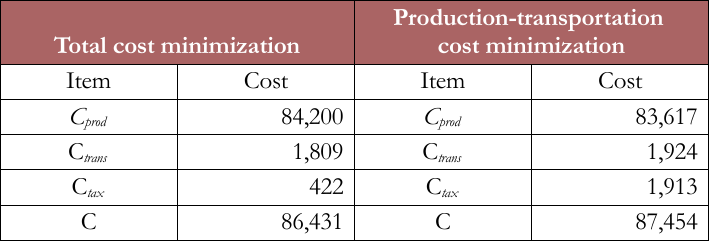
Table 6. Result of